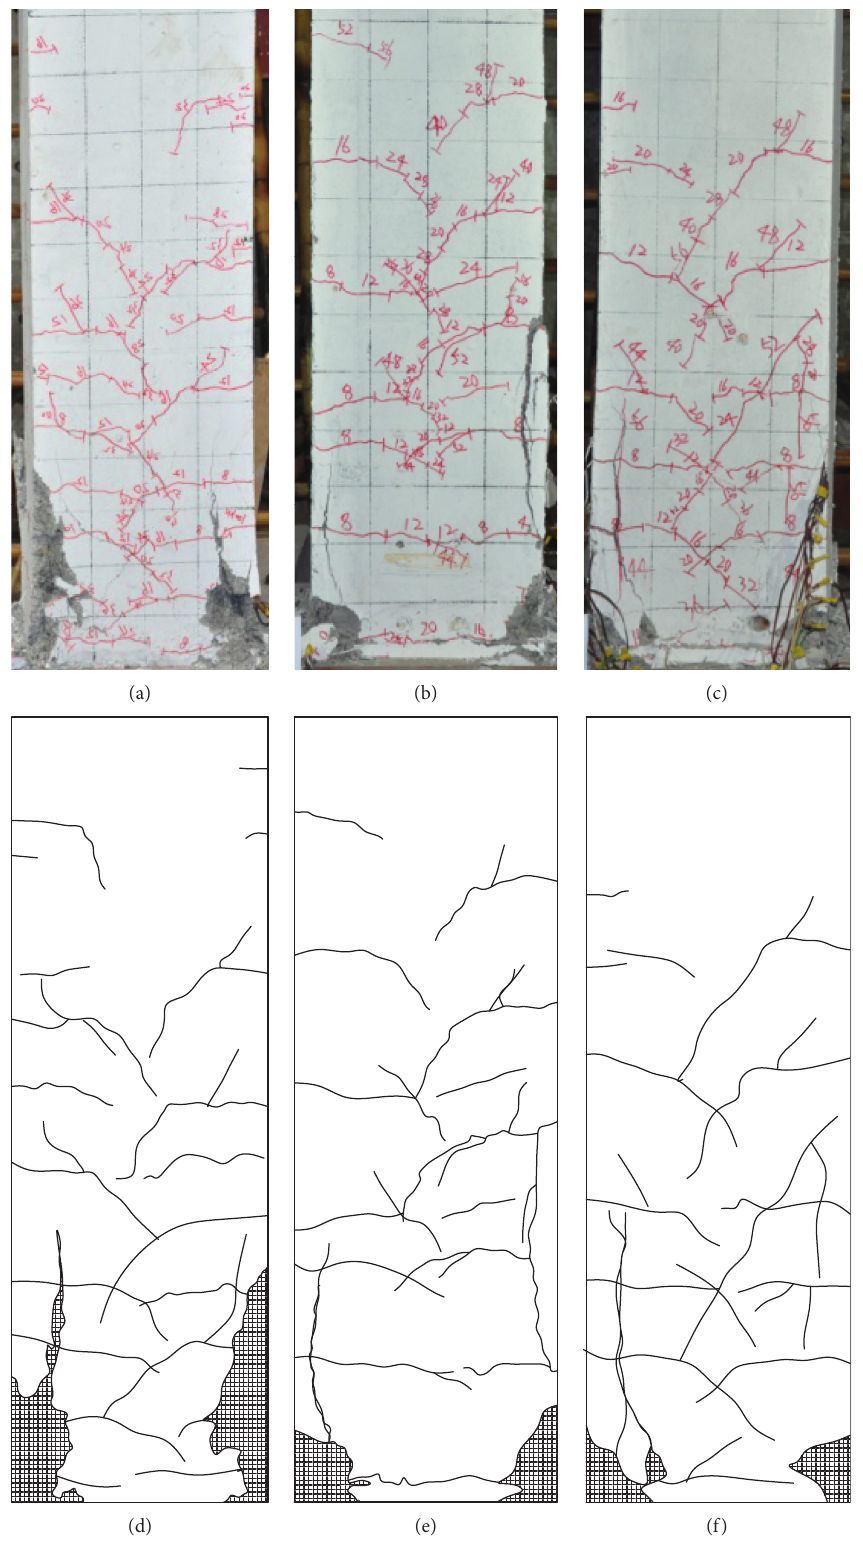
Figure 10: Pictures and illustrations of crack distribution of specimens at displacement limit state. (a) Picture of XZ1. (b) Picture of YZ1. (c) Picture of YZ2. (d) Crack illustration of XZ1. (e) Crack illustration of YZ1. (f) Crack illustration of